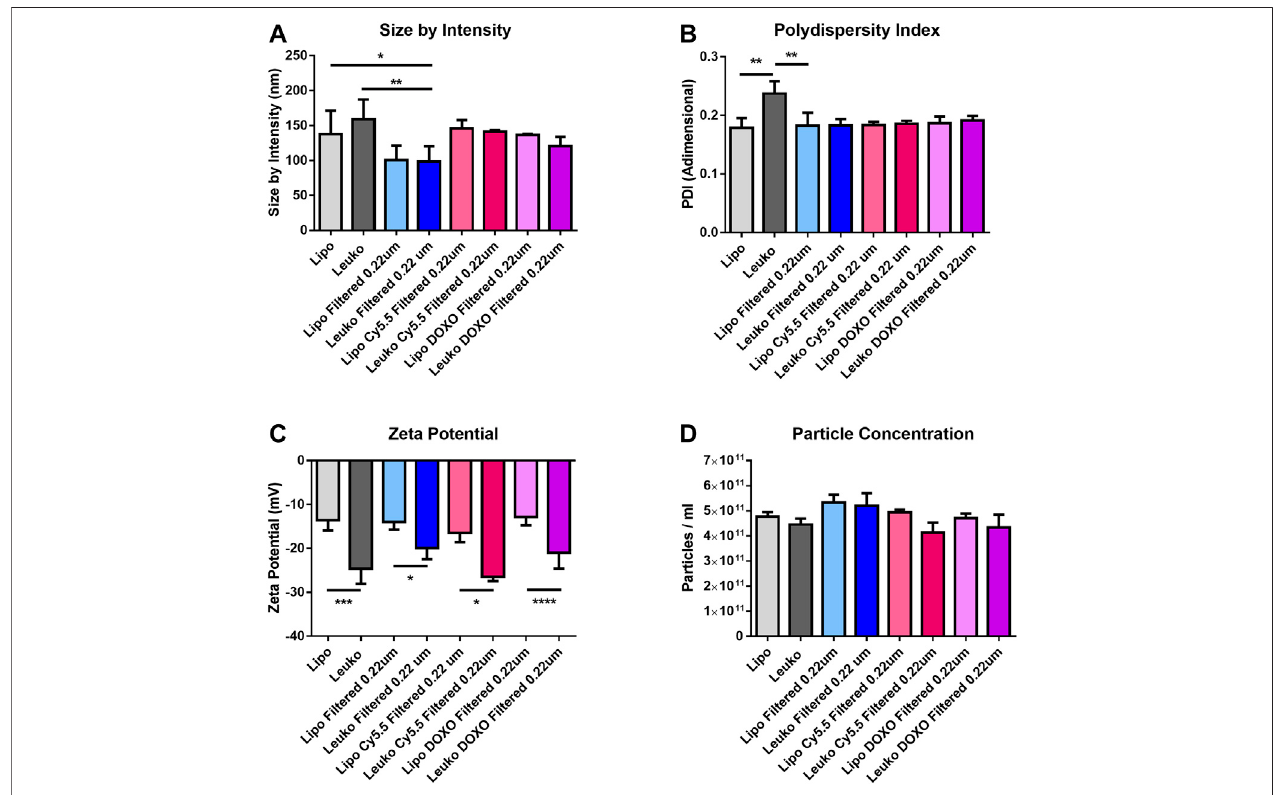
FIGURE 2 | Size by intensity (A) , polydispersity Index (PDI) (B) , and zeta potential (C) measured by DLS for the different Lipo and Leuko formulations. (D) Particles concentrations estimated by particle tracking analysis using the Nanosight ™ platform. ( p ˂ 0.05; pp p ˂ 0.01; *** p ˂ 0.001; pppp p ˂ 0.0001, and n = 3 for all the performed